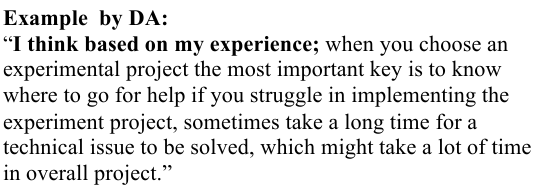
Figure 1. Critical thinking through incorporating other’s ideas